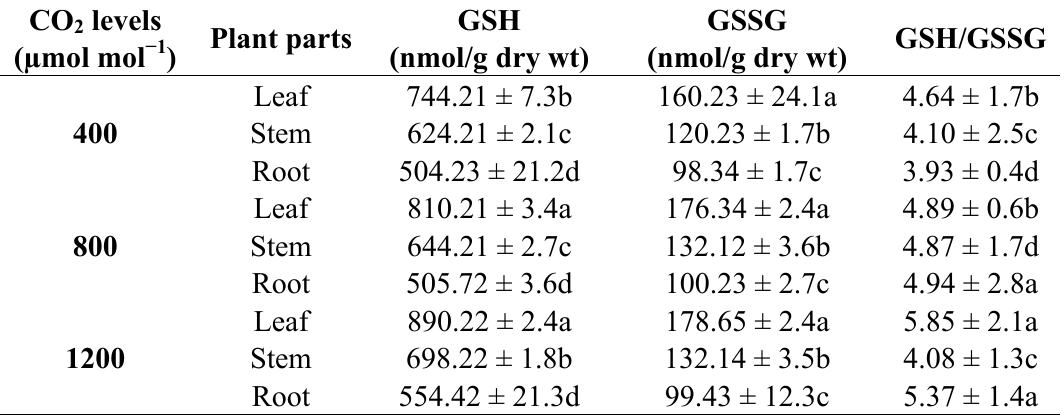
Table 4. Gluthathione (GSH), Oxidised Gluthatione (GSHO) and GSH/GSSG ratio in different part of L. pumila under different CO 2